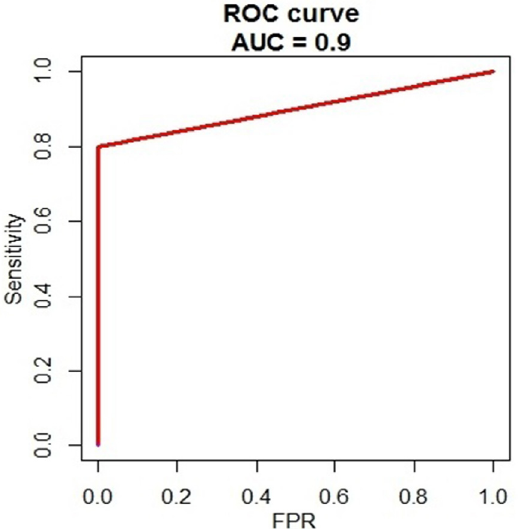
Fig. 6. ROC curves of the proposed method after applying the gene selection process for sample size of